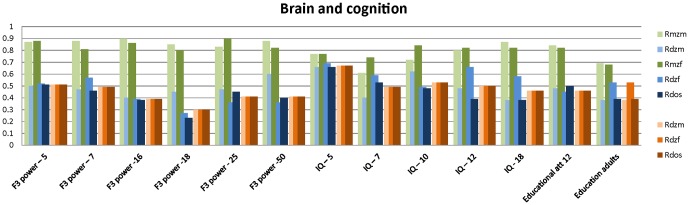
Twin correlations for Brain and Cognition variables.The green bars represent correlations in Monozygotic Male (MZM) twin pairs (light green) and Monozygotic Female (MZF) twin pairs. The blue bars represent correlations in Dizygotic Male (DZM) twin pairs, Dizygotic Female (DZF) twin pairs and Dizygotic Opposite Sex (DOS) twin pairs. The green and blue bars reflect the correlations in a full model, while the orange bars reflect twin correlations for Dizygotic (DZ) twin pairs in the most parsimonious model, with: DZM (light orange), MZF (normal orange), DOS (dark orange).